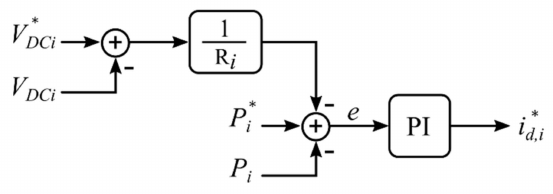
Figure 4. Droop control block diagram.